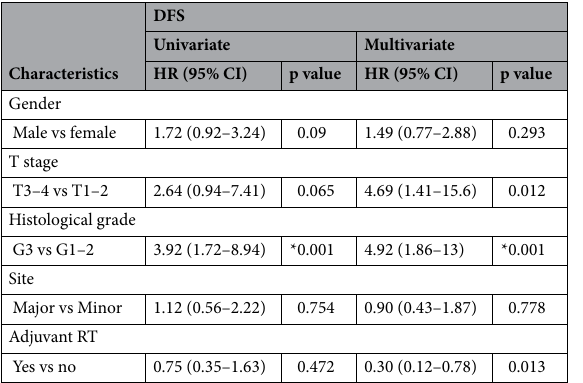
Table 2. Disease-free survival analysis for ACC patients (n = 83). Clinical and pathological risk factors for local–regional recurrence or distant metastasis were analyzed using Multivariable Cox’s proportional-hazards models. HR hazard ratio, CI confidence interval. *n =